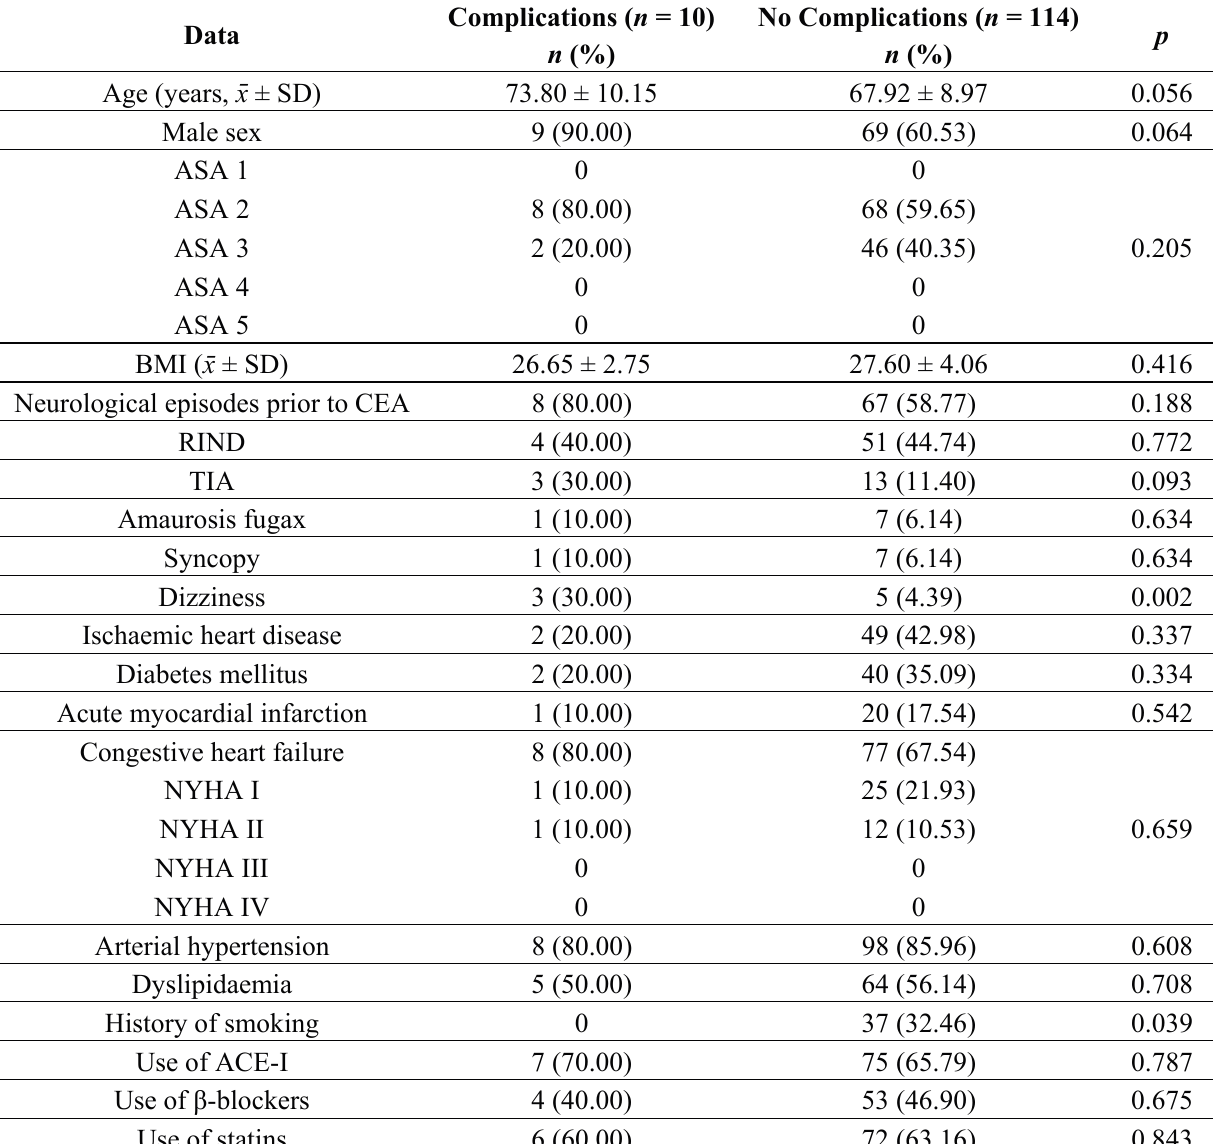
Table 1. Demographic data and concomitant medications in groups with and without 30-day